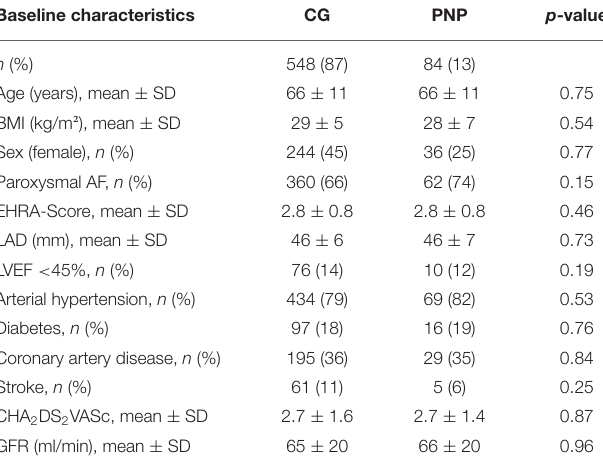
TABLE 1 | Baseline